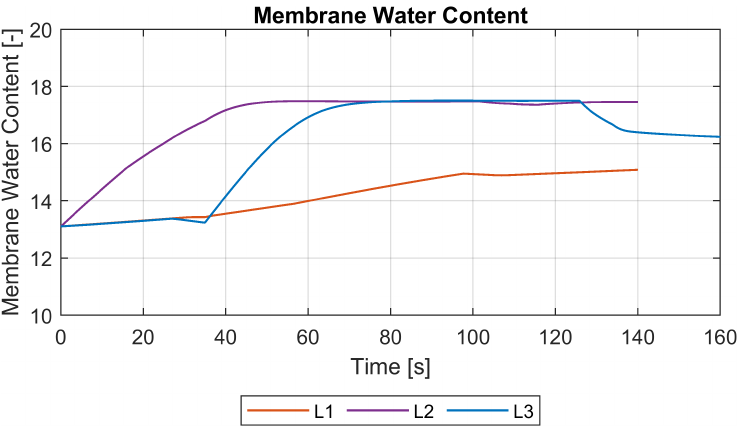
Figure 7. Membrane water content C w for load steps L1, L2 and L3. C w depends on relative humidities at interface to anode GDL and CCL. Max. membrane water content was C w , max =